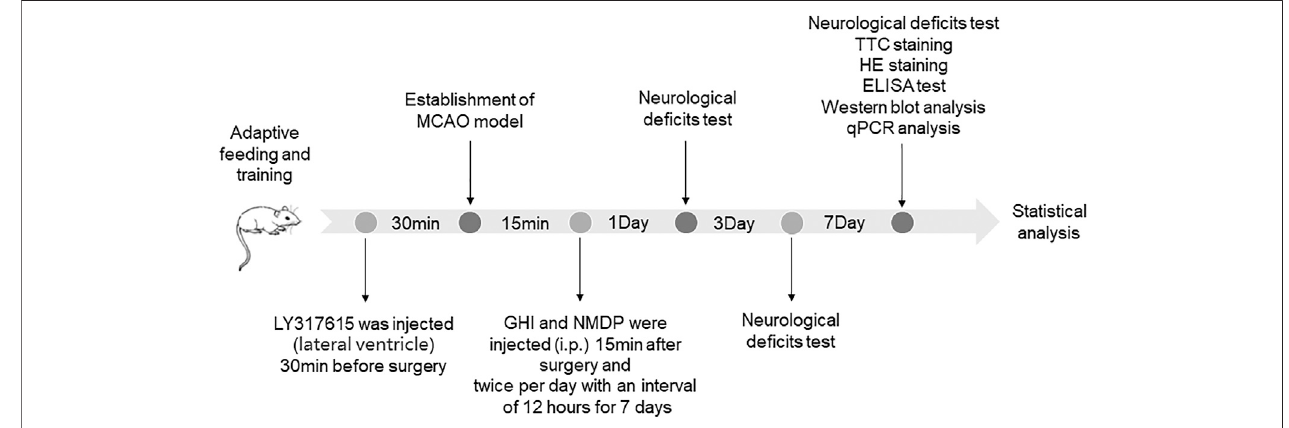
FIGURE 2 | The schedule of the experimental